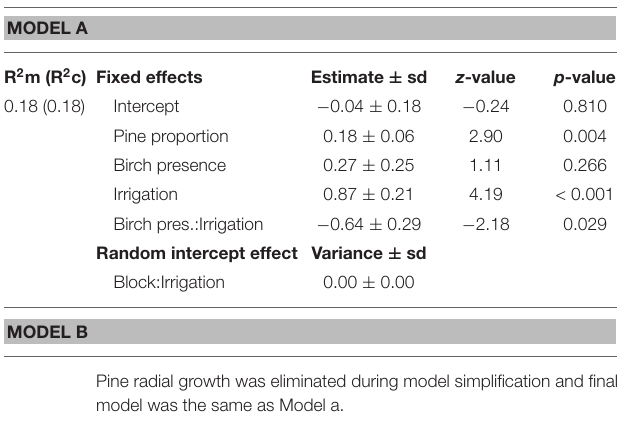
TABLE 2 | Summary of simplified generalized linear mixed effects models (Poisson distribution) of the number of attacks by D. sylvestrella at plot level before (Model a) and after (Model b) introduction of mean pine radial growth as a